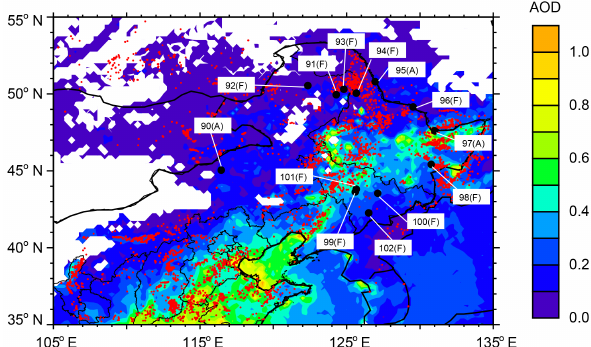
Figure 1. Spatial distribution of the averaged AOD retrieved from Aqua-MODIS over northern China from October 2013 to Jan- uary 2014. The red dots are MODIS active fire locations, and the black dots are the sampling locations. The site numbers begin at 90 in this study, which are numbered in chronological order followed by Wang et al. (2013a) and Ye et al. (2012). “A” and “F” refer to aged snow and fresh snow,